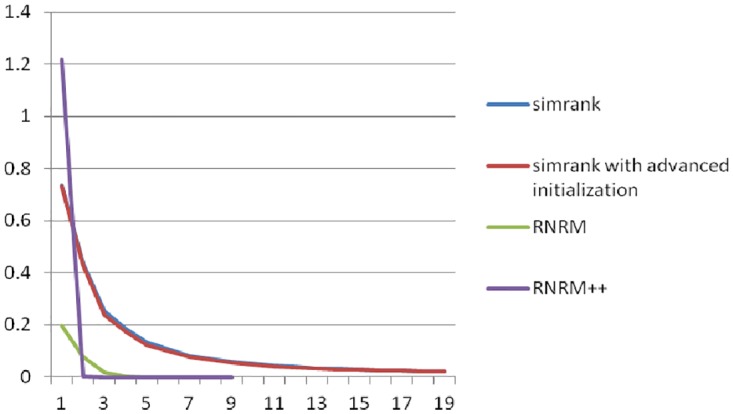
The convergence rates of algorithms using Fig 3.